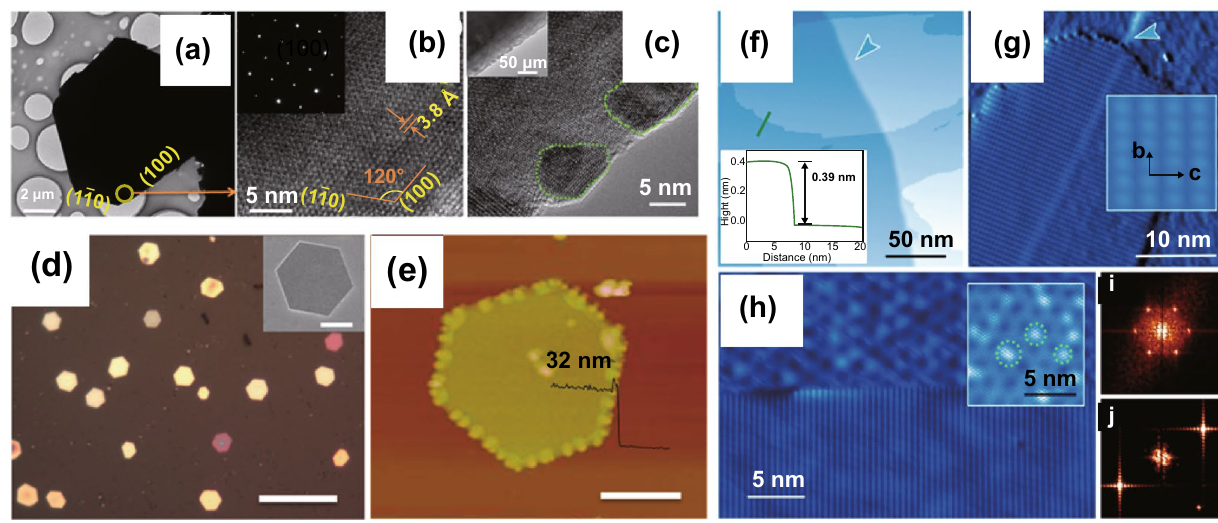
Fig. 3 a , b TEM and high‑resolution TEM (HRTEM) images of a 2D Te flake. Inset of b shows the electron diffraction pattern. c HRTEM image of the Te flake edge. d Optical microscope (OM) image of 2D Te flakes, scale bar = 4 μm, with inset of a single flake. e AFM image of 2D Te flake, scale bar = 2 μm, with the step height profile of the flake edge. Adapted with permission from [67]. Copyright 2014, American Chemi‑ cal Society. f STM image of 2D Te grown on graphene with a step height profile of the edge. g High‑resolution STM of monolayer Te flake. h STM image of the reconstructed graphene (upper and inset) and single‑layer Te flake (lower). i , j Fast Fourier transforms of graphene and single‑ layer Te flake. Adapted with permission from [68]. Copyright 2017, American Chemical